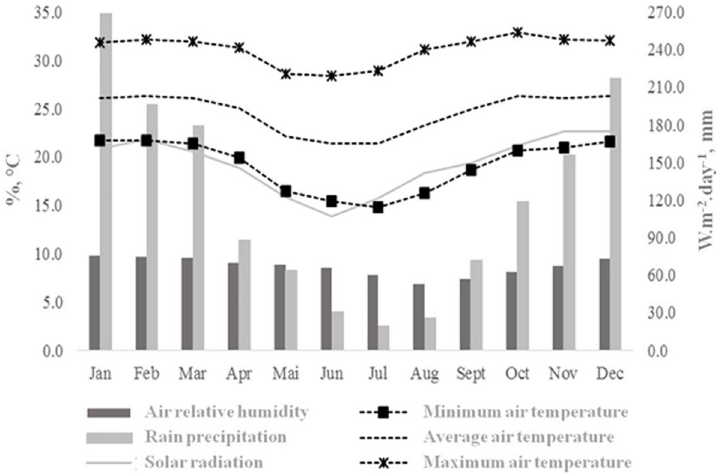
Fig 1. Provisional climatic norms of the region where the experiment was realized, in Mato Grosso do Sul State, Brazil, between 1992 and 2013 (adapted from Flumignan et al. [8]).